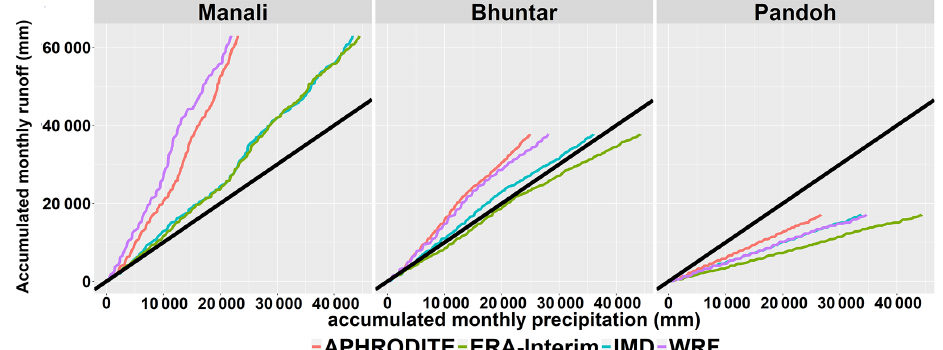
Figure 13. Accumulated precipitation and discharge.